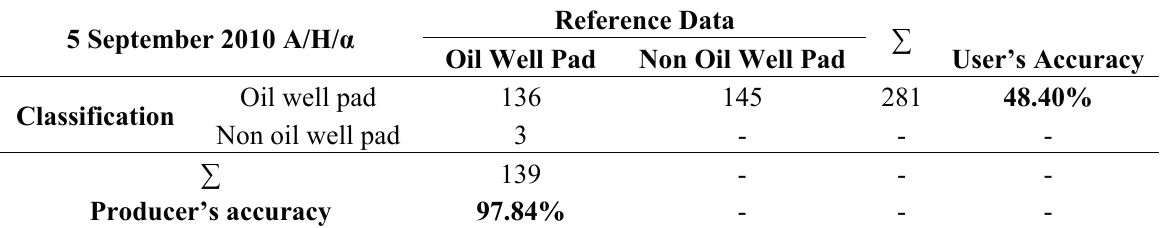
Table 4. Number-based accuracy assessment for TerraSAR-X acquisition 5 September 2010—A/H/ α .